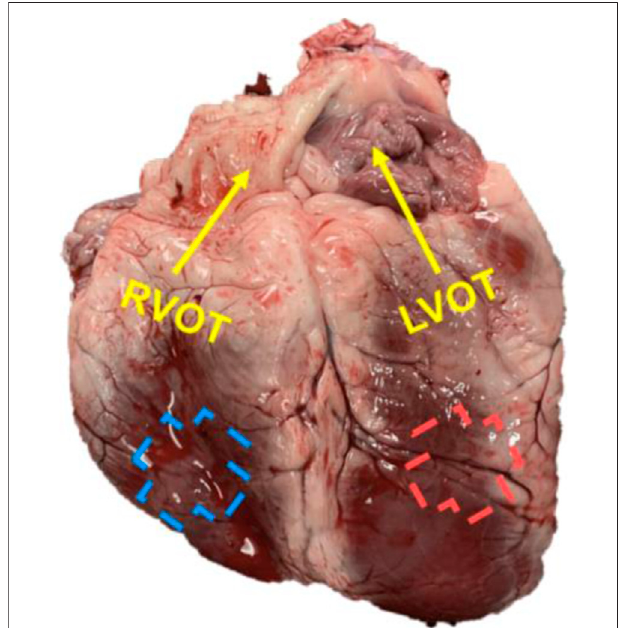
FIGURE1| Arepresentative image ofthe ovine heart withthe labeling of the out fl ow (OT, longitudinal) direction for each ventricle.